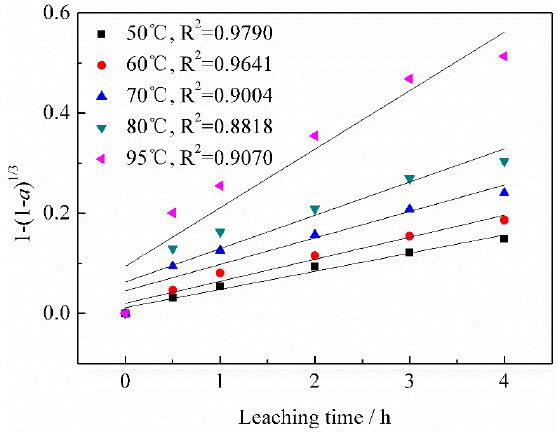
Figure 15. Fitting plots of 1 − (1 − α ) 1/3 versus leaching time t at different leaching temperatures. A fitting plot of 1 − 2 α /3 − (1 − α ) 2/3 vs. t is shown in Figure 16. It can be observed that the linear